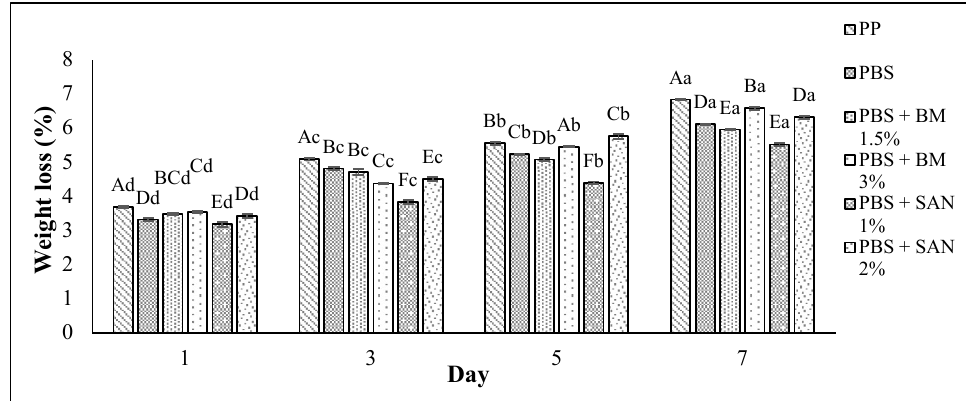
Figure 5. The weight loss values of chicken breast fillets stored in PP container and PBS film laminated tray during storage at 4 ◦ C for seven days. Note: PP: polypropylene microwavable container (control); PBS: PBS film (untreated); PBS + BM 1.5%: PBS film + 1.5% Biomaster silver; PBS + BM 3%: PBS film + 3% Biomaster silver; PBS + SAN 1%: PBS film + 1% SANAFOR; PBS + SAN 2%: PBS film + 2% SANAFOR. Error bars indicate standard deviation (n = 3). The different A–F capital letters are significantly different ( p < 0.05) among treatment for each day. The different a–d lowercase letters are significantly different ( p < 0.05) among storage day for each